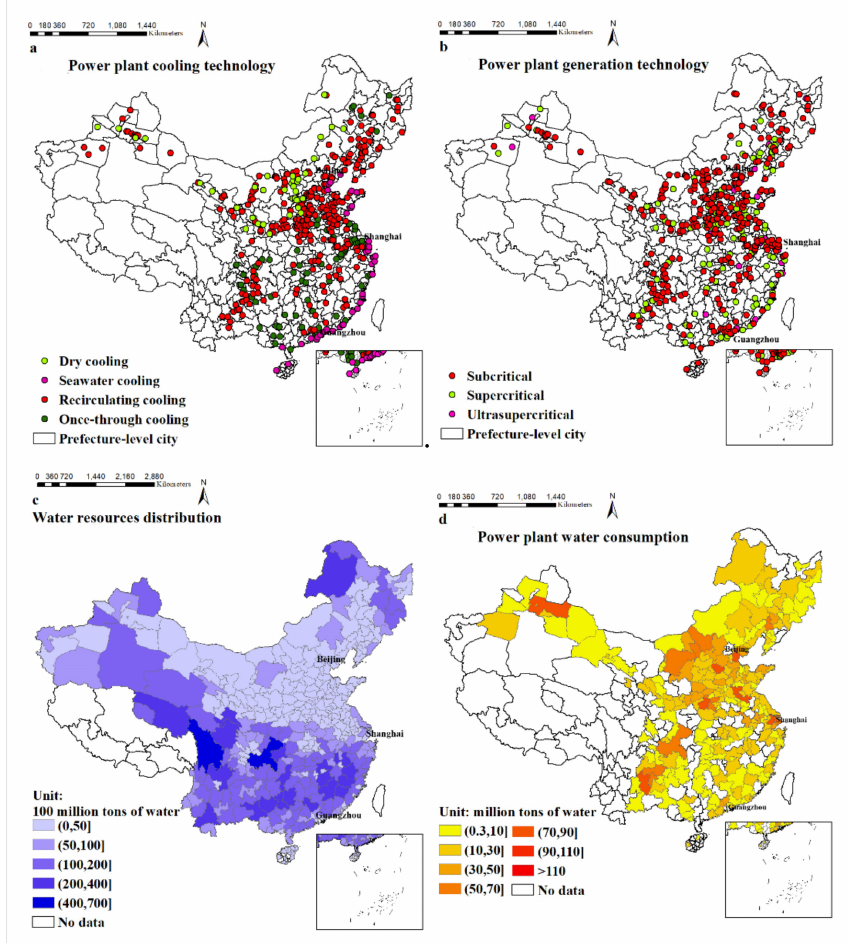
Figure 3. Distribution of qualified power plants and their water consumption. ( a ) The distribu- tion of 591 qualified power plants by different cooling technologies, namely once-through cooling, recirculating cooling, dry cooling, and seawater cooling. ( b ) The distribution of power plants by different power generation technologies, namely subcritical, supercritical, and super-supercritical power plants. ( c ) The average water resource distribution of prefecture-level cities in China, see calcu- lation in Equation (1), for the calculation process. ( d ) The spatial distribution of water consumption without CCS implementation in 234 cities where 591 qualified power plants are